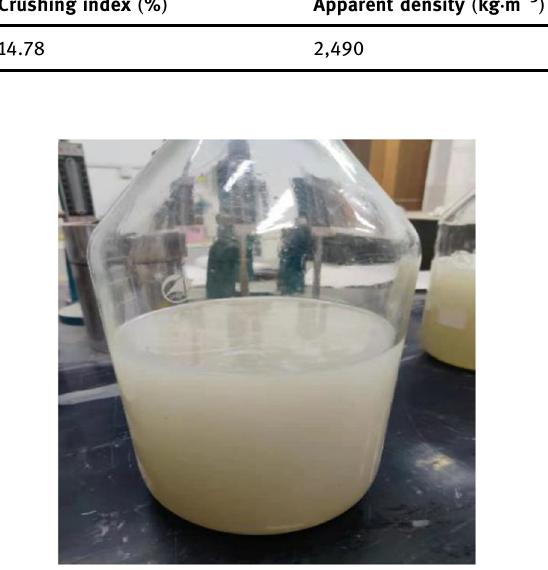
Table 2: Performance indicators of recycled coarse aggregate Particle size ( mm )